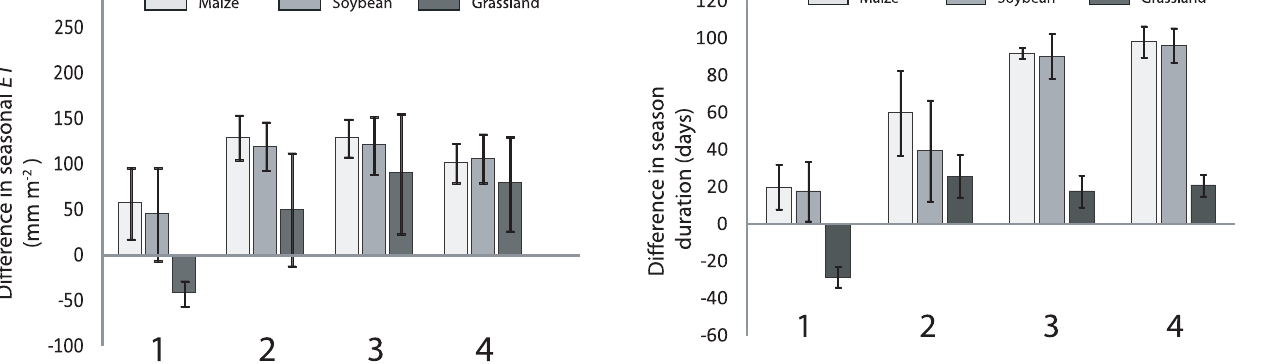
Fig. 7. Consequences of biases in VegET estimates and in total sea- sonal evapotranspiration: (1) ET obtained through VegET param- eterized by K cp from EDPM; (2) ET derived via VegET driven by K cp from AVHRR based climatologies; (3) ET derived via VegET driven by K cp from MODIS based long term averages; and (4) ET derived via VegET driven by K cp . Error bars show standard errors.